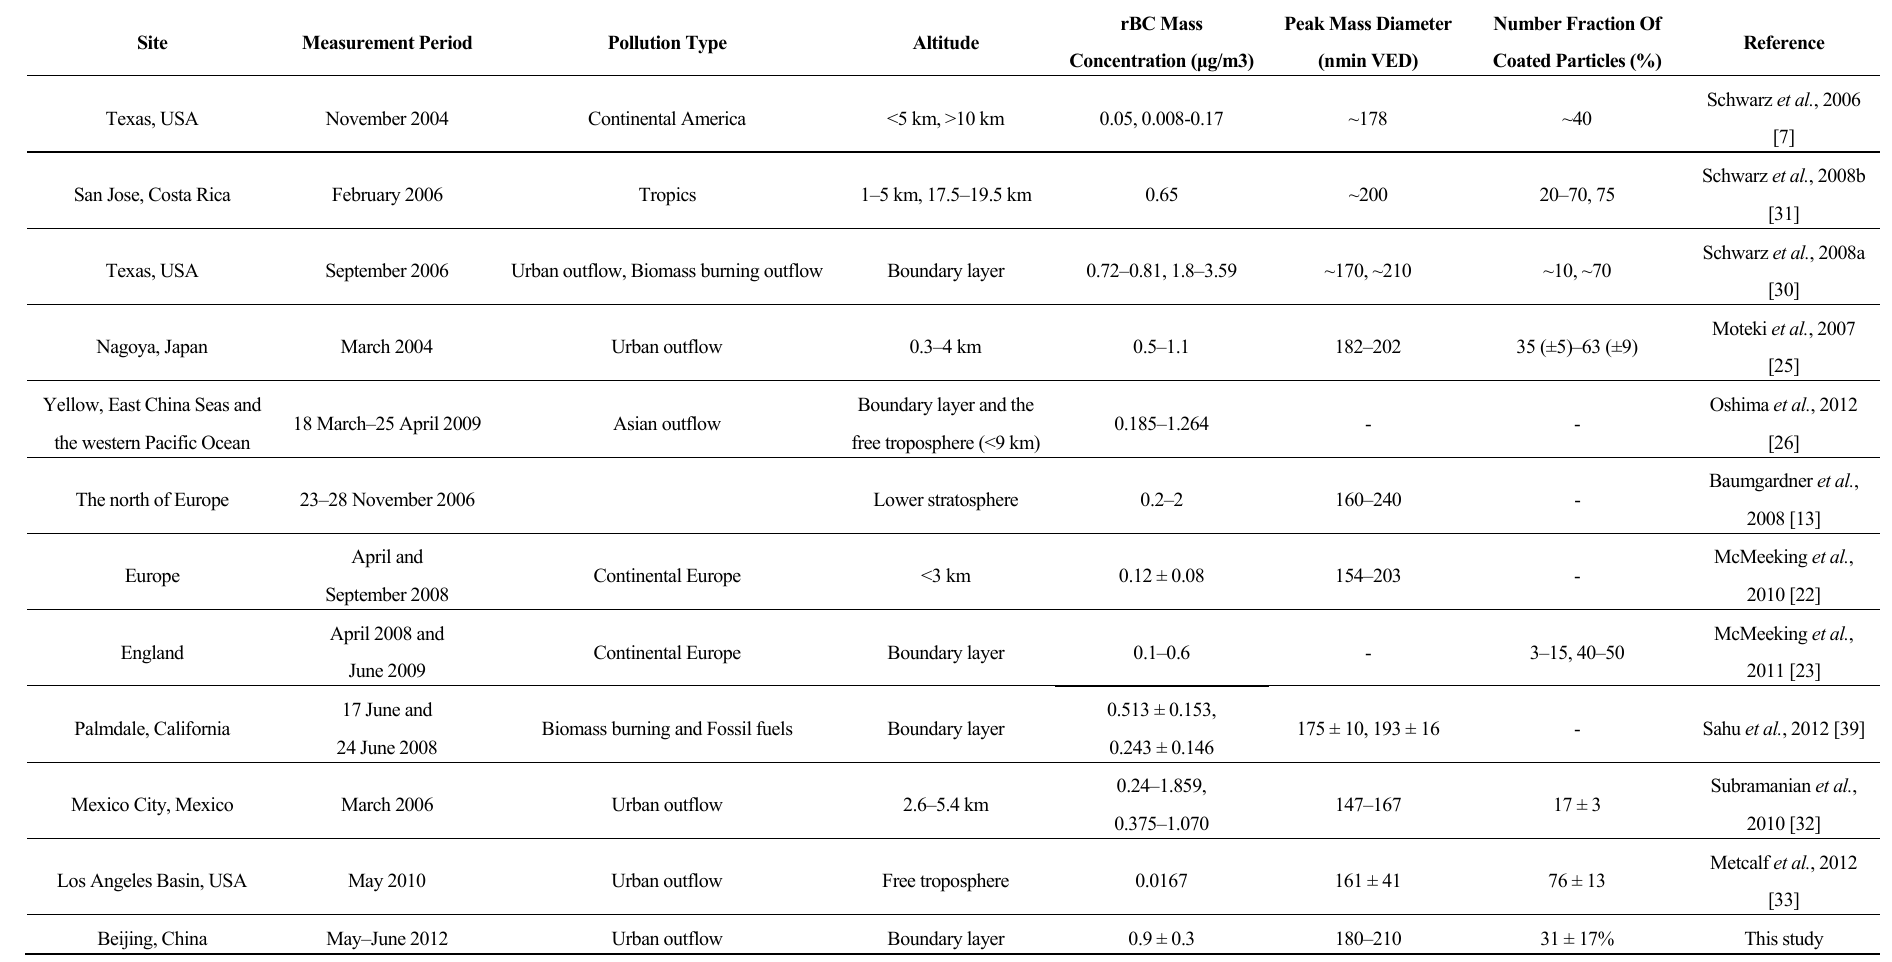
Table 3. Summary of rBC measurements by airborne SP2 in different regions of the